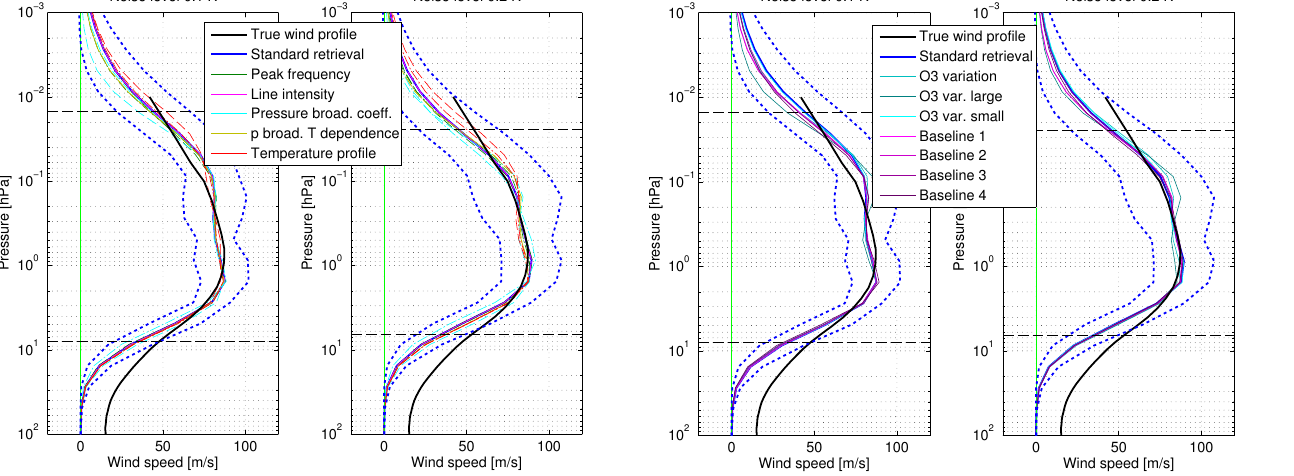
Figure 13. As Fig. 11. Instead of the results for perturbed forward model parameters, the mean profiles for situations with atmospheric ozone profiles strongly deviating from the a priori are plotted. The graph also contains the mean profiles for input spectra which are af- fected by a baseline with a typical amplitude and period for WIRA. Baselines 1, 2, 3 and 4 refer to different phases, i.e. are shifted in spectral